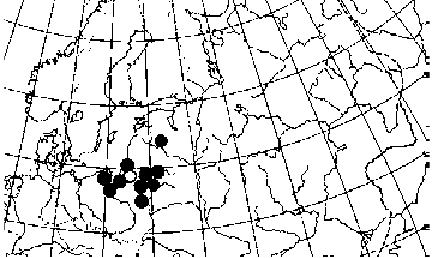
Fig. 6. Distribution of Leptogium biatorinum in Eastern and East Central Europe (cid:2) records more than 50 year old, (cid:3) modern records